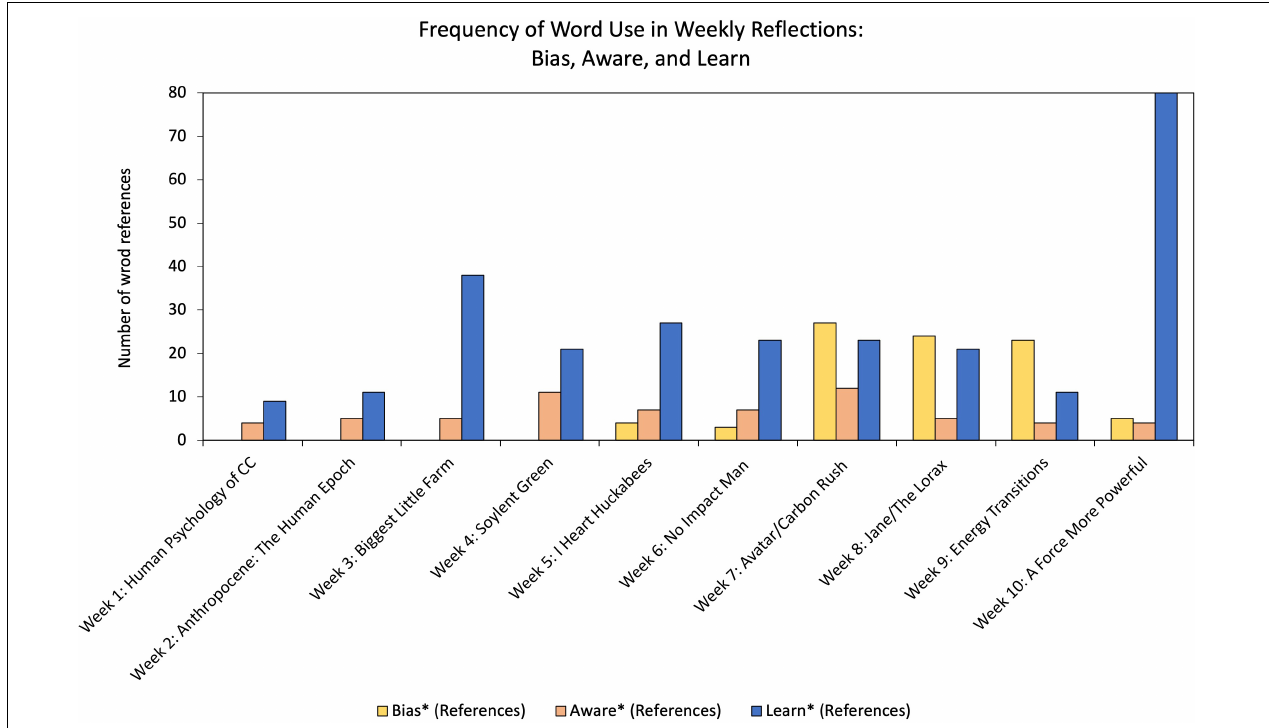
FIGURE 3 | Frequency of “bias,” “aware” versus “learn” words in reflection assignment over 10 weeks, using stemmed text query (which includes words with the same root, e.g., biased, awareness, and learning).